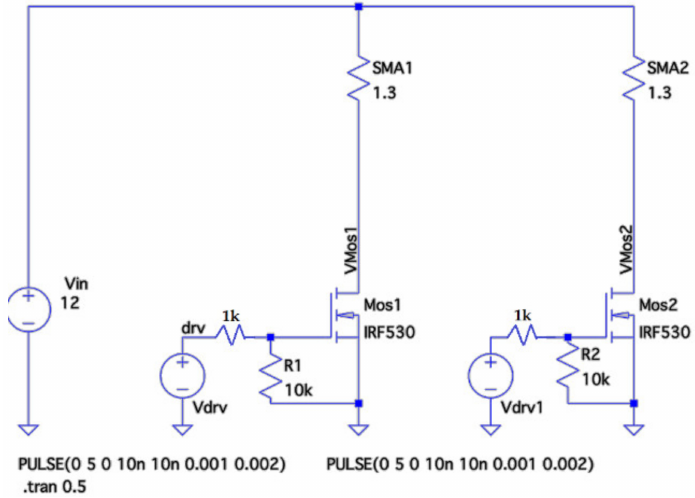
Figure 8. General schematic in